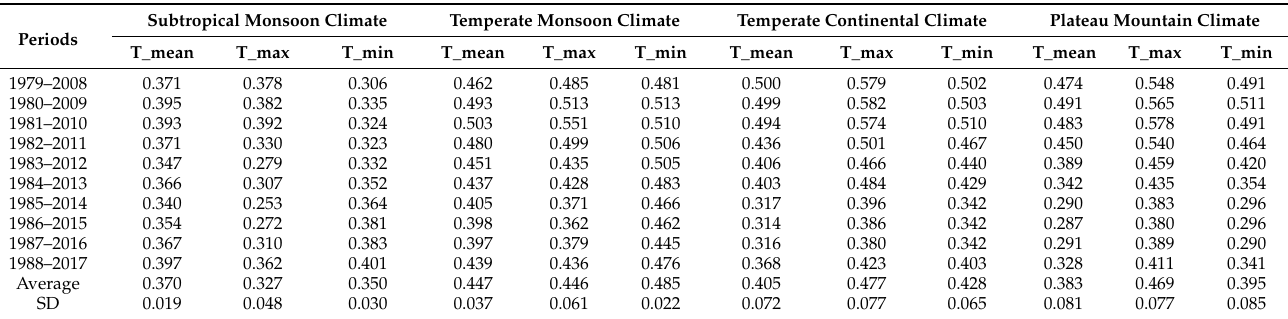
Table 3. Temperature increasing rates at different periods for the four different climate zones within Gansu Province at each period ( ◦ C/10a). Table 4. Mutation time of annual mean temperature for the four different climate zones within Gansu Province during the period 1979 ‒ 2017 (°C/10a).